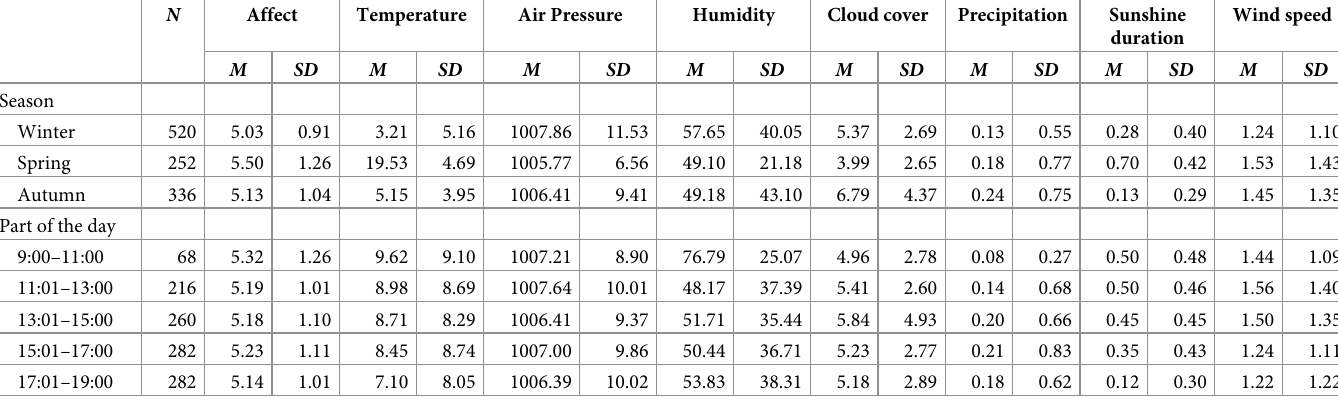
Table 1. Descriptive characteristics of affect and weather